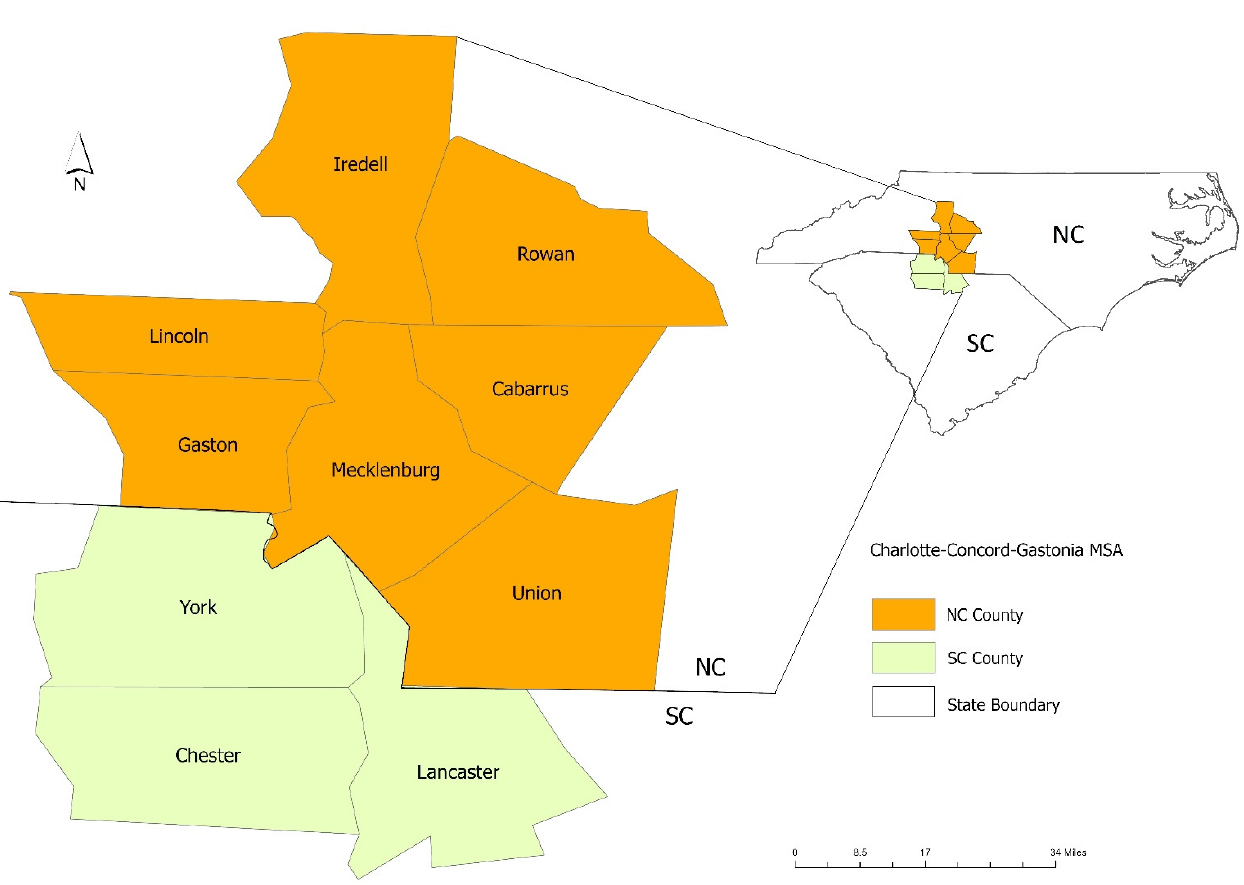
Figure 1. Map of the Charlotte–Concord–Gastonia MSA.